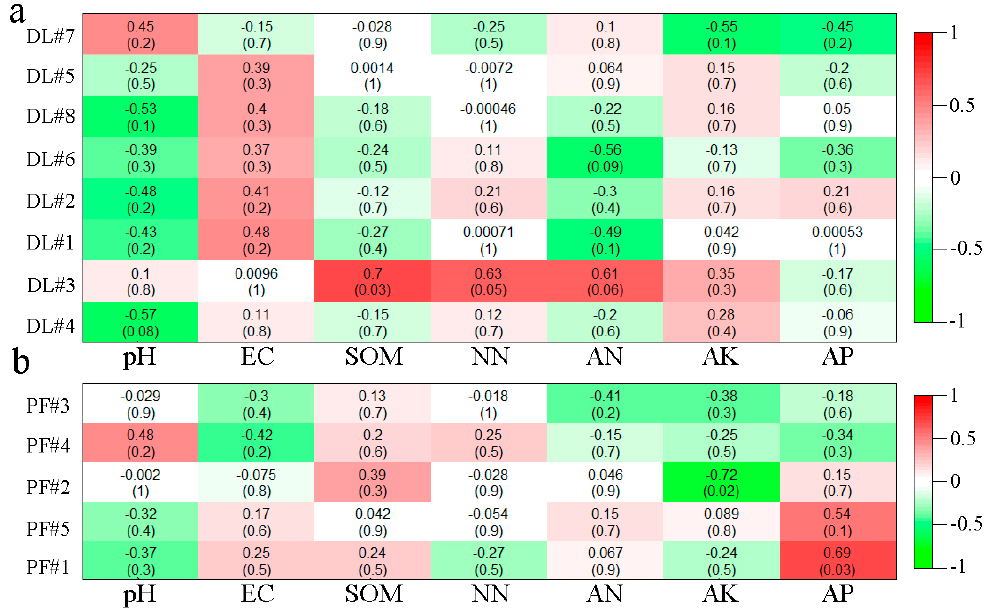
Figure 7. Heatmap analysis of bacteria module correlations with environmental factors in DL ( a ) and PF ( b ).